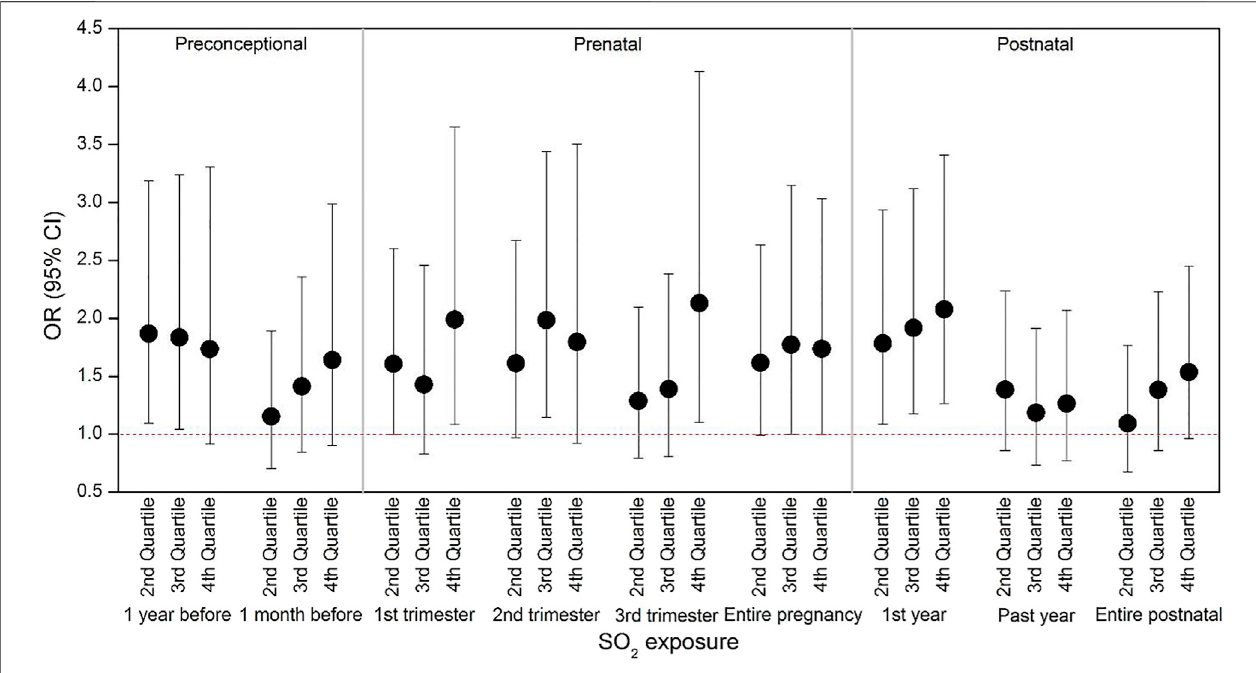
FIGURE 1 | Risk of laryngitis for outdoor SO 2 at different exposure levels. We divided the exposure levels into four quartiles based on Table 1 : Q1 = < 25th percentile;Q2=intherangeof25th-50thpercentiles;Q3=intherangeof50th — 75thpercentiles;Q4= > 75thpercentile.TheoddsratioatQ1wasthereference(OR= 1), and OR (95% CI) varied considering the covariates in Table 1 as well as the outdoor temperature listed in Supplementary Table S2 in each time window.